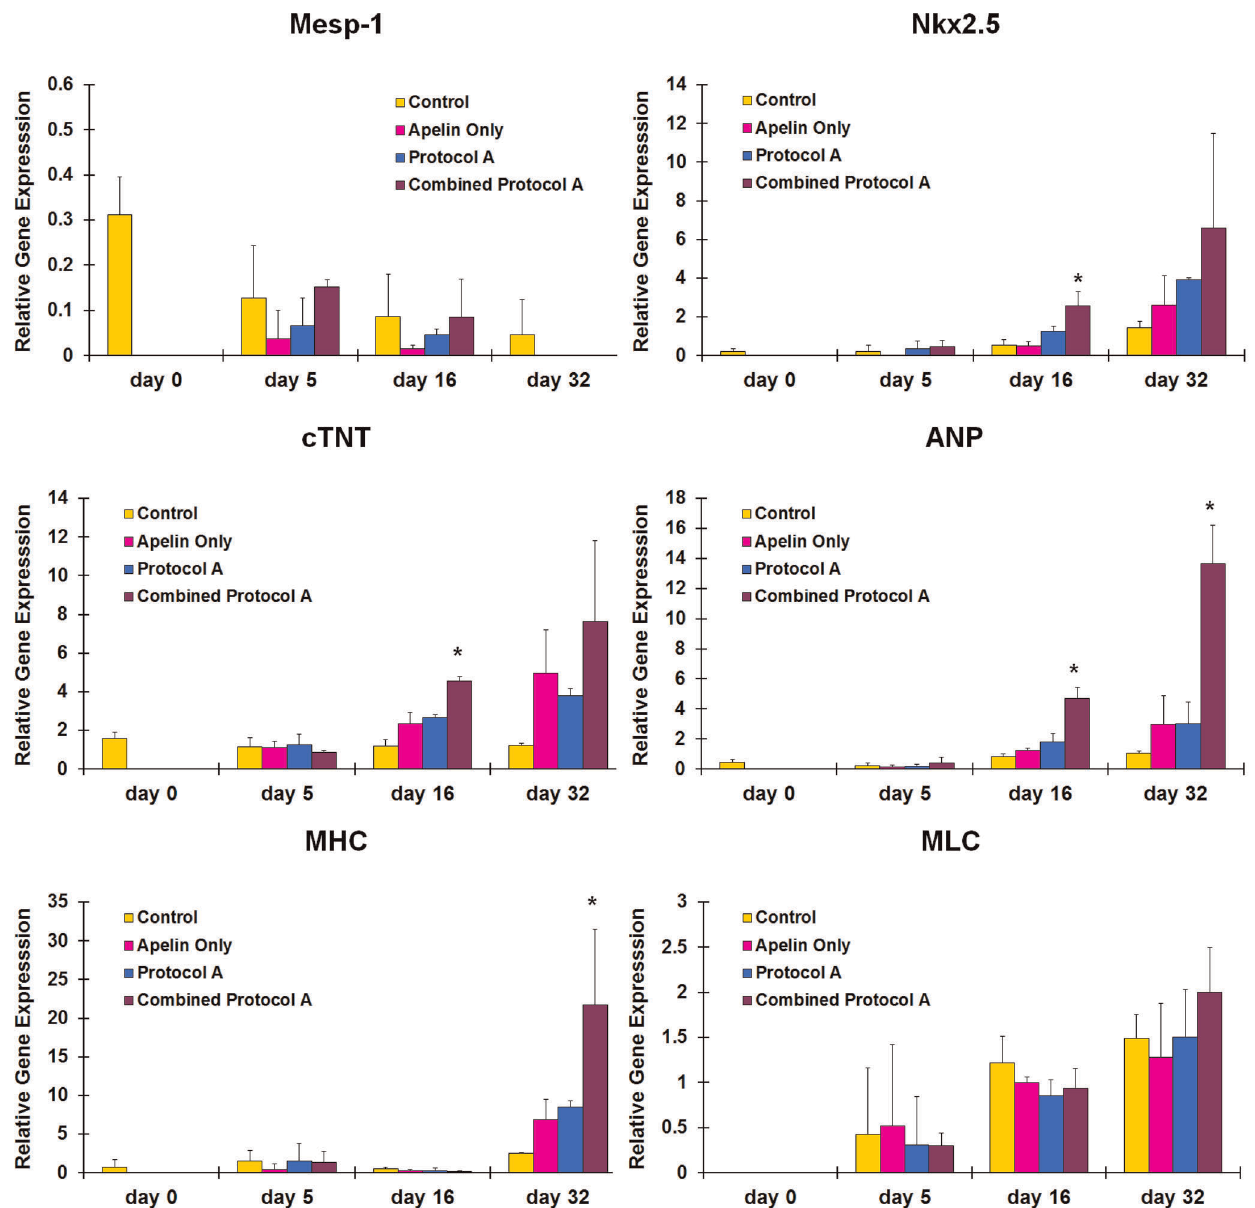
Figure 5. Synergistic effects of apelin on hESC cardiac gene expression using Combined Protocol A. (A) Down-regulation of Mesp-1 is observed in all 4 protocols, (B) Nkx2.5 (an early cardiac transcriptional factor, indicative of cardiac progenitor phenotype) is up-regulated in the combined protocol A at day 16, (C) cTNT (cardiac troponin T, a muscle contractility regulatory protein, indicative of a mature cardiac phenotype) is up-regulated in the combined protocol A at day 16, (D) ANP (atrial natriuretic peptide, a protein peptide secreted by mature cardiomyocyte, indicative of a mature cardiac phenotype) is up-regulated after day 16, (E) MHC (myosin heavy chain, a muscular motor protein, indicative of a mature cardiac phenotype) is up-regulated at day 32, and (F) MLC (myosin light chain, a muscular motor protein, indicative of a mature cardiac phenotype) is up-regulated over time for all groups (*p , 0.05 Combined Protocol A vs. other treatment groups).